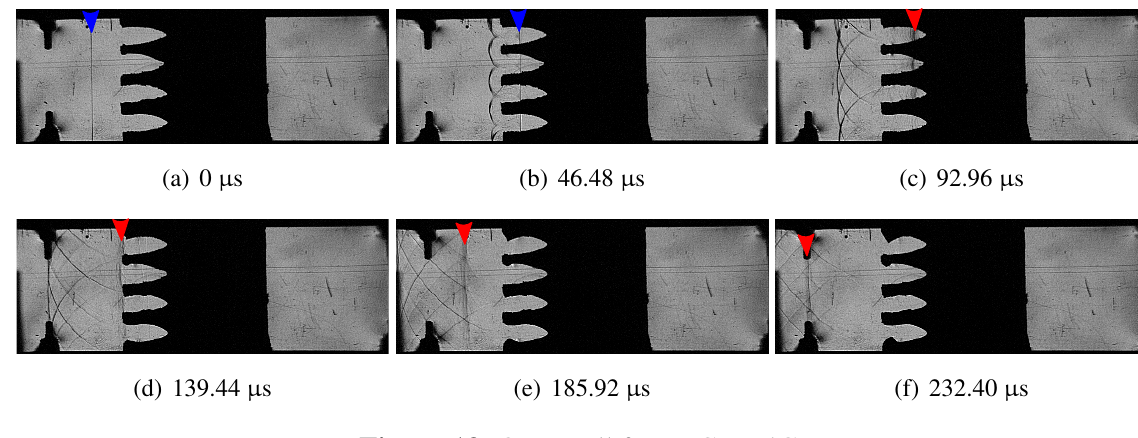
Figure 13. Open cell foam, Case 4C.